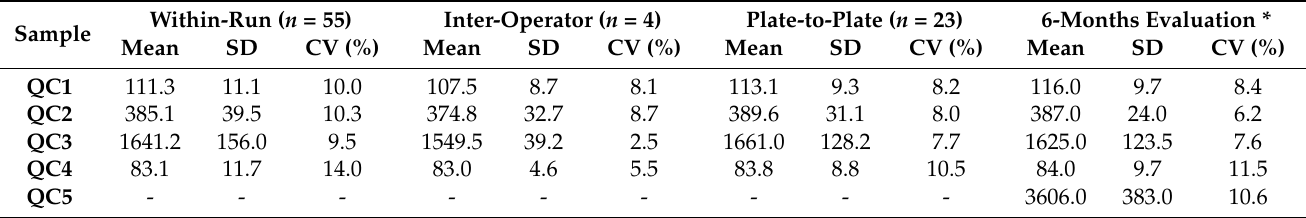
Table 1. CK-MM assay precision; mean concentrations are in ng/mL.